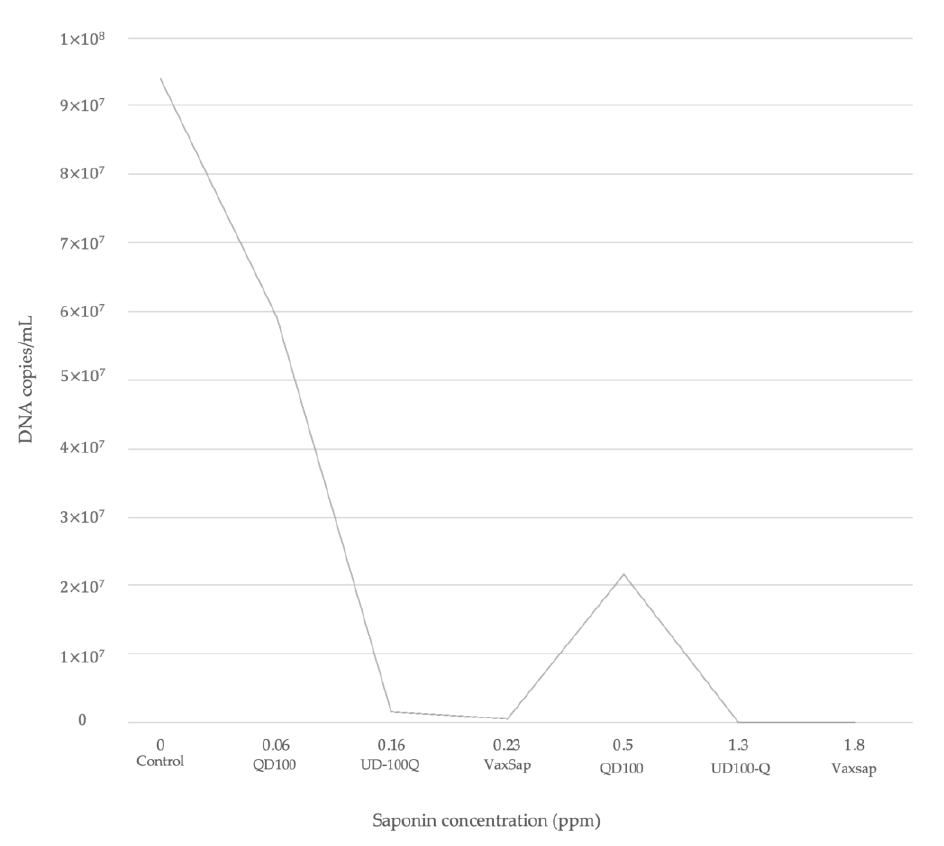
Figure 2. Reduction of P. salmonis (Mean DNA concentration) according to saponin content for each quillaja